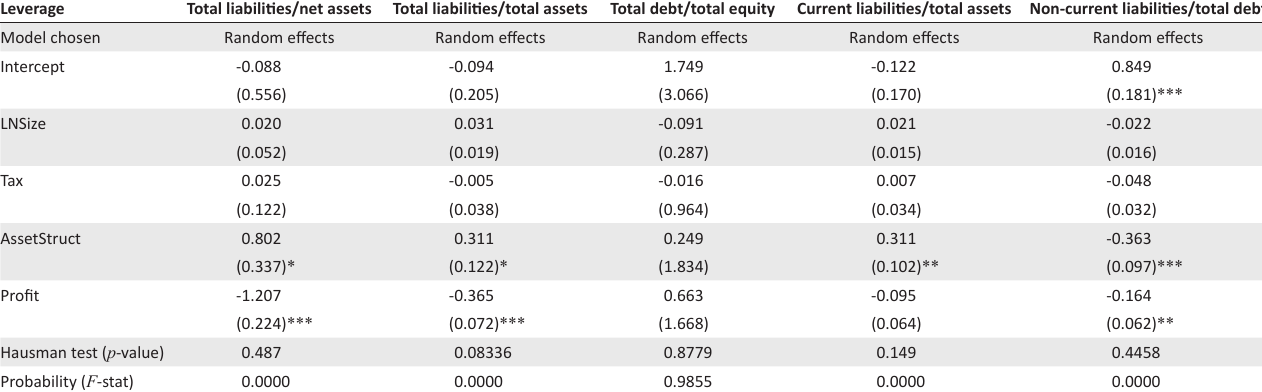
TABLE 11: Regression results: Eqn 2 – Alternative-Exchange-listed firms. Leverage